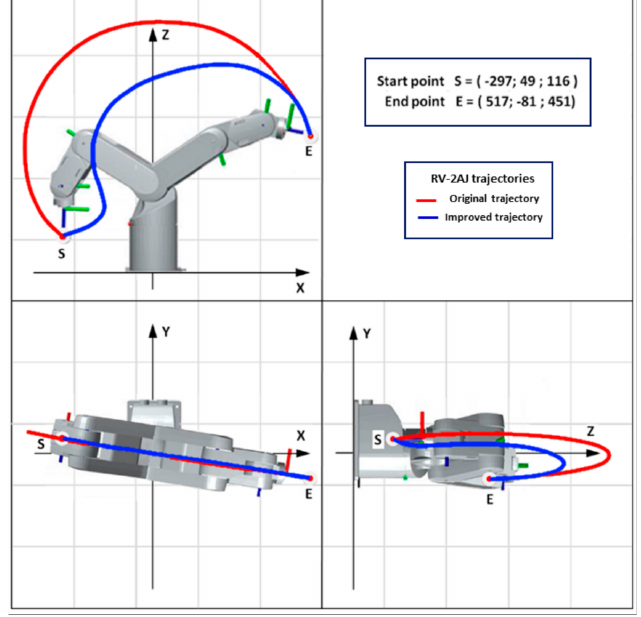
Figure 3. The trajectories of the RV-2AJ arm in three